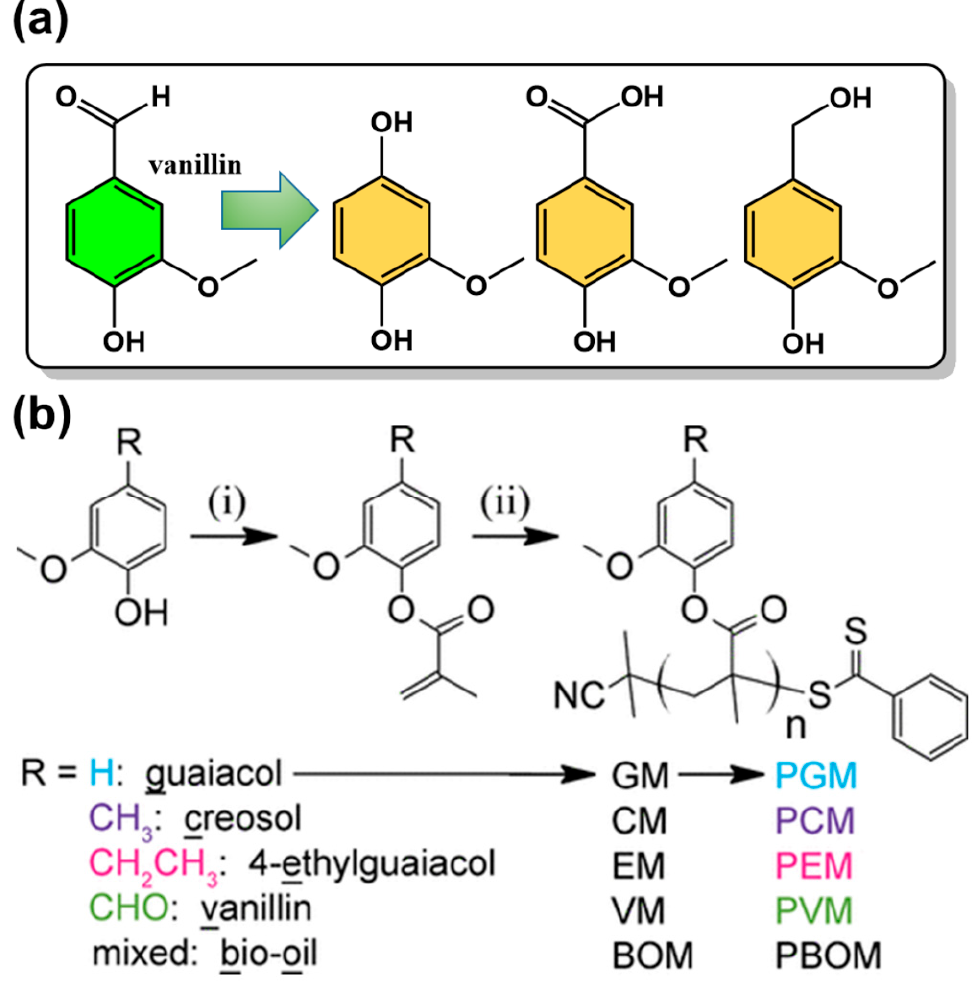
Figure 6. ( a ) Representative platform compounds derived from vanillin and ( b ) synthetic route of vanillin-based methacrylate monomers and the corresponding polymers. Reprinted/adapted with permission from Ref. [71]. Copyright 2016, American Chemical Society.